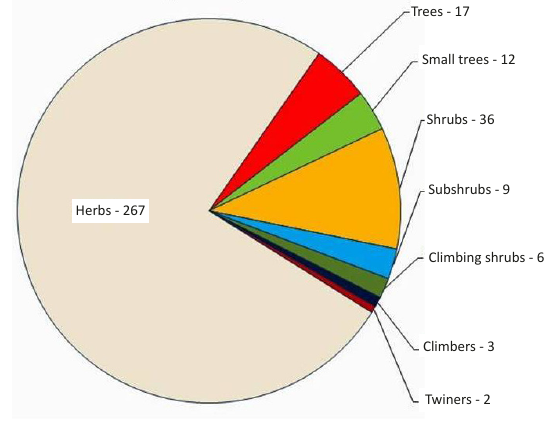
Figure 3. Habit wise break up of the addtions to the flora of Sirmaur District, Himachal Prades (352 taxa)